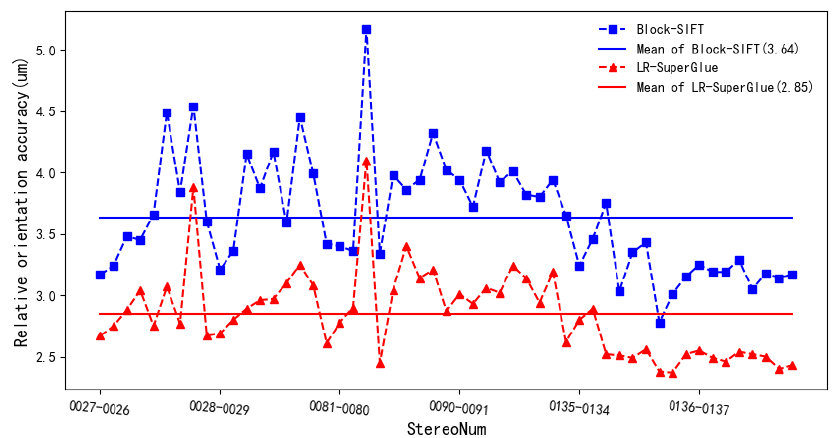
Figure 9. Relative orientation accuracy (unit weighted errors). The camera pixel size is 4.6 µ m. Relative orientation refers to the process of restoring the relative positional relationship of two photos in a stereo pair. Through the relative orientation, it is possible to achieve the intersection of pairs of rays of the corresponding points, achieving the purpose of constructing a stereo model.